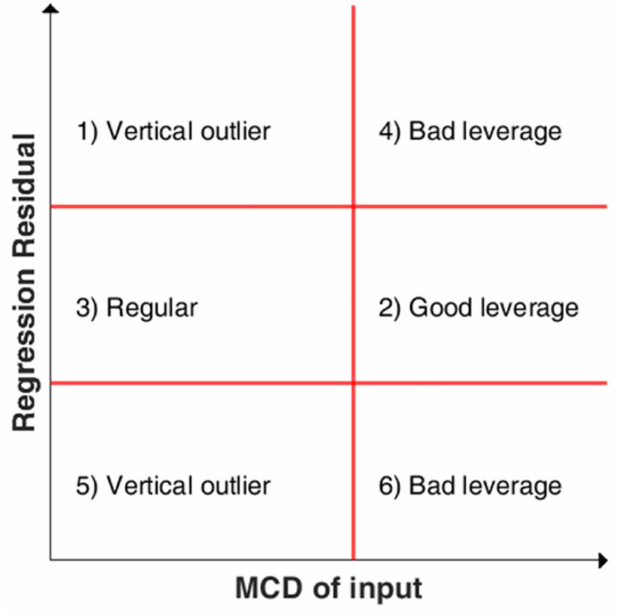
Figure 2. Graphical representation of residual outlier